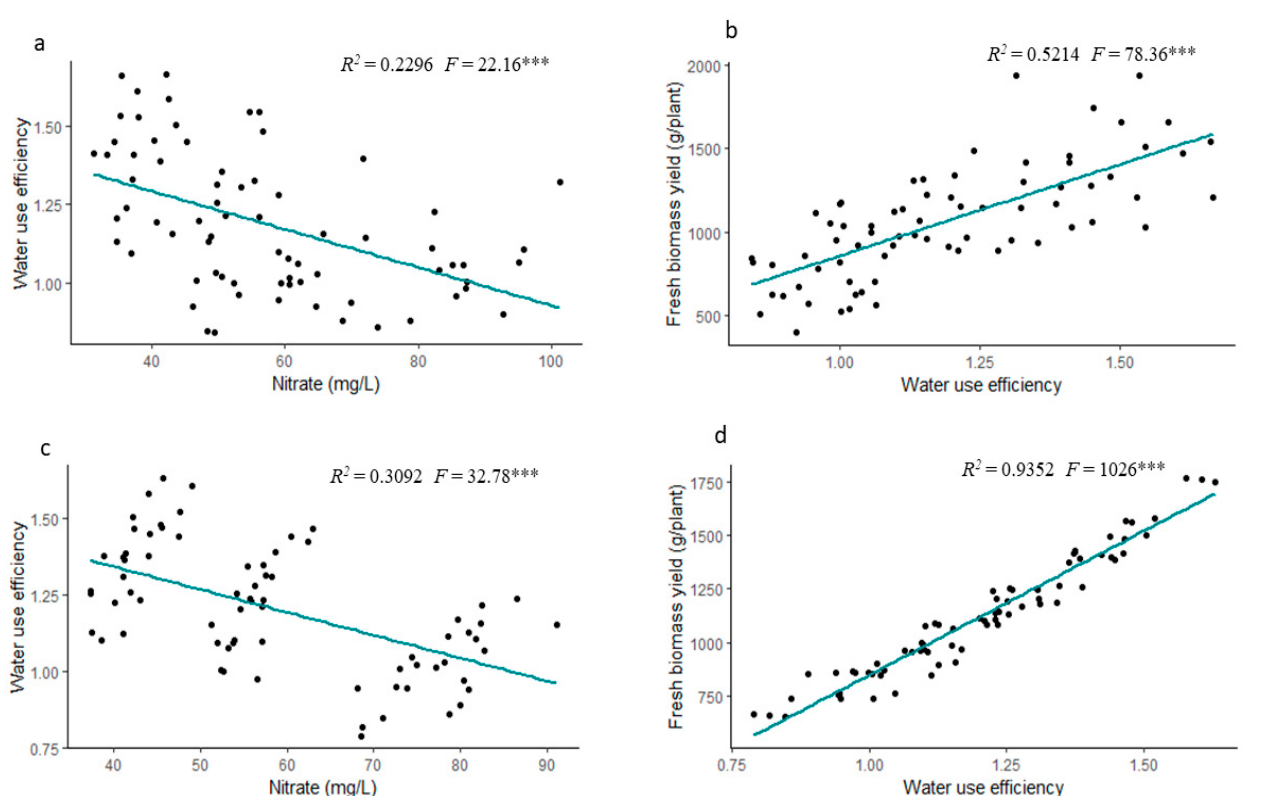
Figure 7. Regression plots showing the linear relationship between water-use efficiency and nitrate accumulation in squash fruits in ( a ) 2020 and ( c ) 2021 and between fresh biomass yield and water-use efficiency in ( b ) 2020 and ( d ) 2021. R 2 , regression coefficient of determination; F, calculated F-statistic value; ***, significant at p ≤ 0.001.